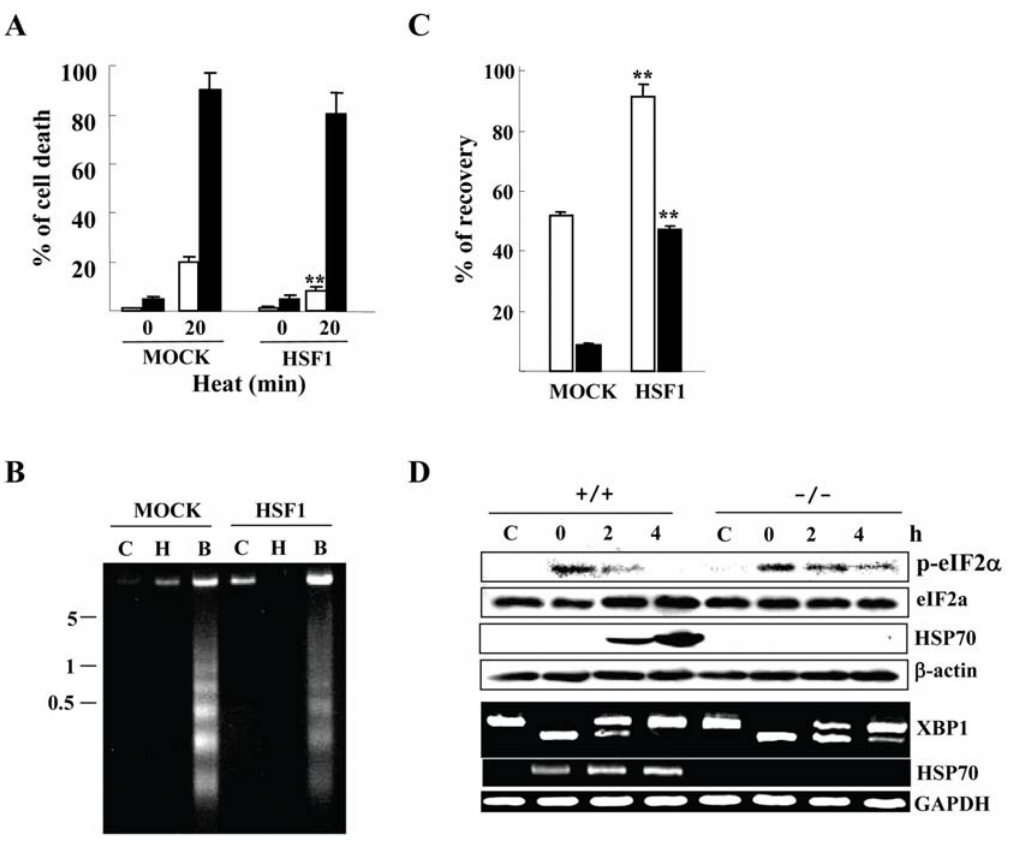
Figure 8. HSF1 rescue into HSF --/- MEFs. A ) Cell death at 24 h after heat exposure (42.5 u c) for 20 min with (closed) or without (open bars) 0.5 mM H 2 O 2 pretreatment. **, P , 0.01 compared with MOCK transfectants. B ) DNA fragmentation. Small molecular DNAs were prepared from cells (C: control, H: 42.5 u c for 10 min, B: heat and 0.5 mM H 2 O 2 ) 24 h after heat exposure. Numbers indicate molecular weights (kilo bases). C ) Effect of H 2 O 2 pretreatment on refolding activity. Cells were transiently co-transfected with the wild-type pHSF1 expression vector (HSF1) or its vehicle (MOCK) with the pGRE/RL-TK reporter genes, treated with 5 mM dexamethazone for 10-12 h, treated by thermal preconditioning as described in Fig. 6 D , exposed to heat (42.5 u c for 20 min) with (closed) or without (open bars) 0.5 mM H 2 O 2 pretreatment, incubated for 5 h and luciferase activity was measured. **, P , 0.01 compared with MOCK transfectants. D ) eIF2 a phosphorylation and XBP1 splicing. After exposure to heat (43.5 u c for 20 min), HSF + / + and -/- MEFs were harvested at the indicated hours. The eIF2 a phosphorylation and HSP70 expression were evaluated by western blots using the indicated antibodies. Anti- b -actin antibody shows equal loading of protein samples. XBP1 splicing and HSP70 mRNA expression were evaluated by RT-PCR. GAPDH mRNA levels ensure that the RNA was correctly quantified. In A and C , error bars indicate the mean 6 S.D. of data from three separate